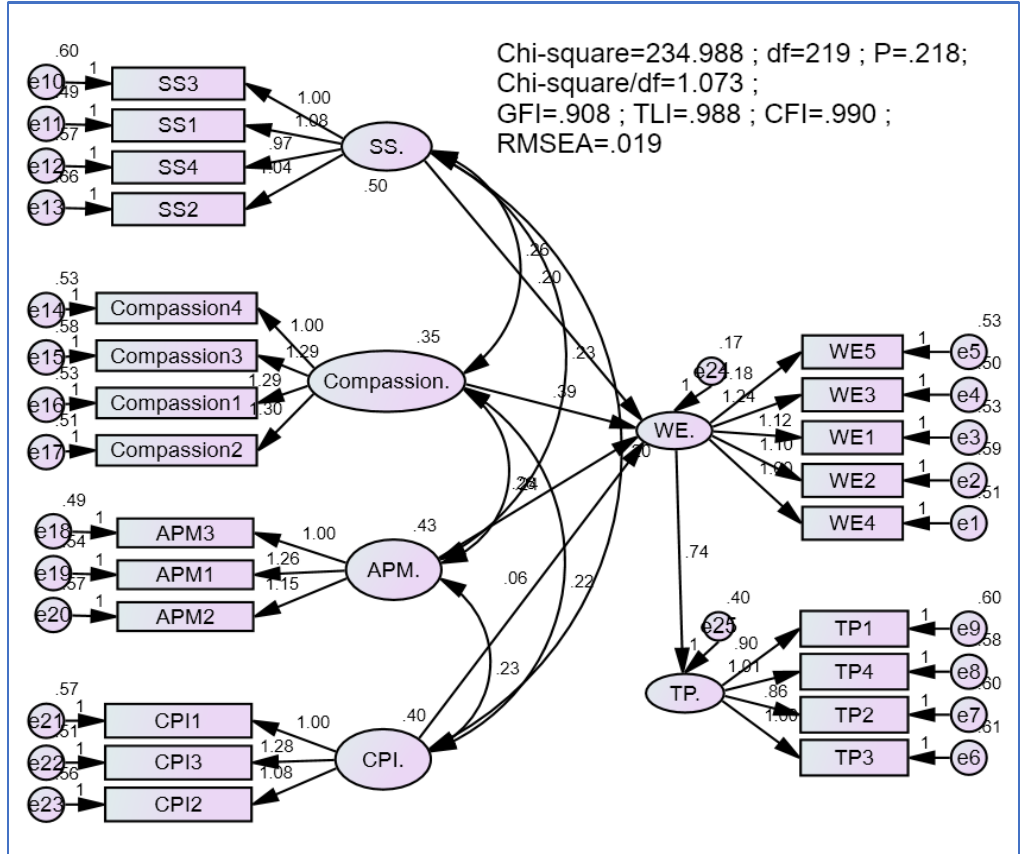
Figure 2: The Results of SEM Analysis (Source: Authors’